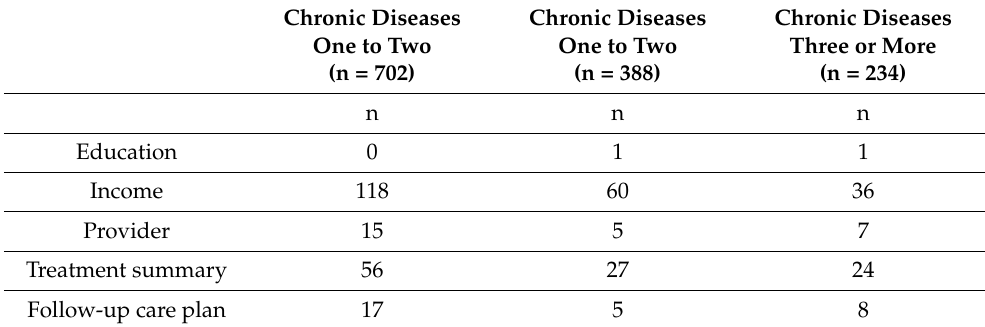
Table A1. Missing values for each factor among breast cancer survivors a